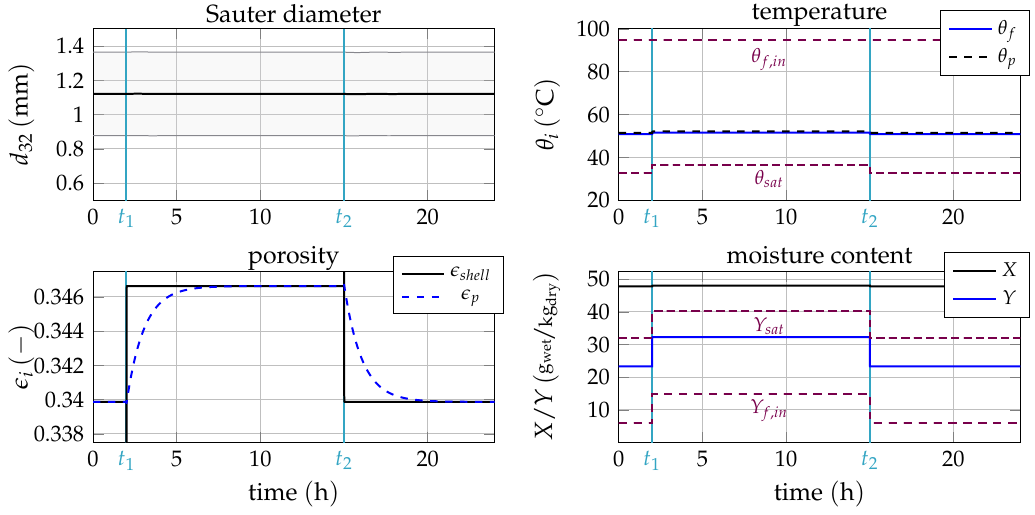
Figure 12. Simulation results of fourth scenario: the disturbance of the moisture content of the fluid at inlet Y in at t 1 results in small variations of the thermal conditions and particle